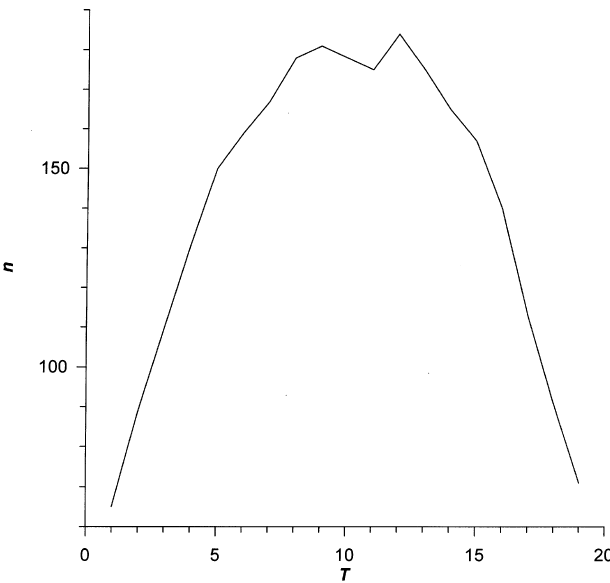
Fig. 5. Dependence of the number n of data points located within the time window T (cid:255) 2h (cid:20) t (cid:20) T (cid:135) 2h, on the position of this window. The value of t is the time lapse between intensity measurement and the onset of the storm